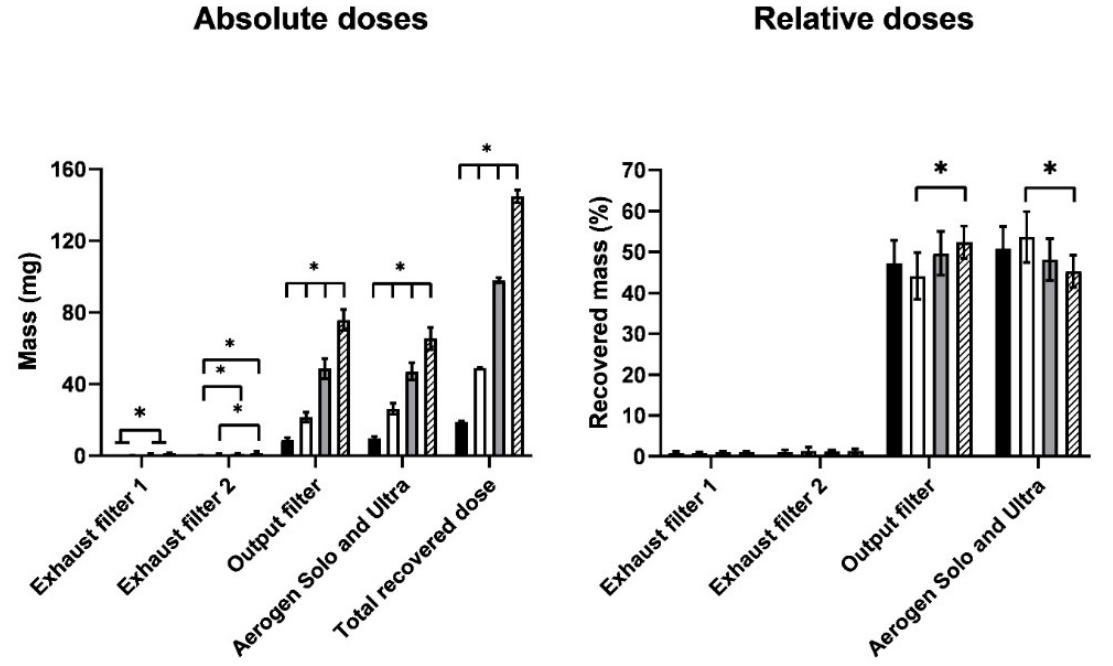
Figure 2. Absolute and relative doses of HCQS on the various parts of the dose output setup. The four bars represent 1 mL of 20 mg/mL (black), 1 mL of 50 mg/mL (white), 1 mL of 100 mg/mL (gray), and 1.5 mL of 100 mg/mL (hatch). Data presented as mean ± standard deviation ( n = 9). Statistical difference indicated by * ( p <